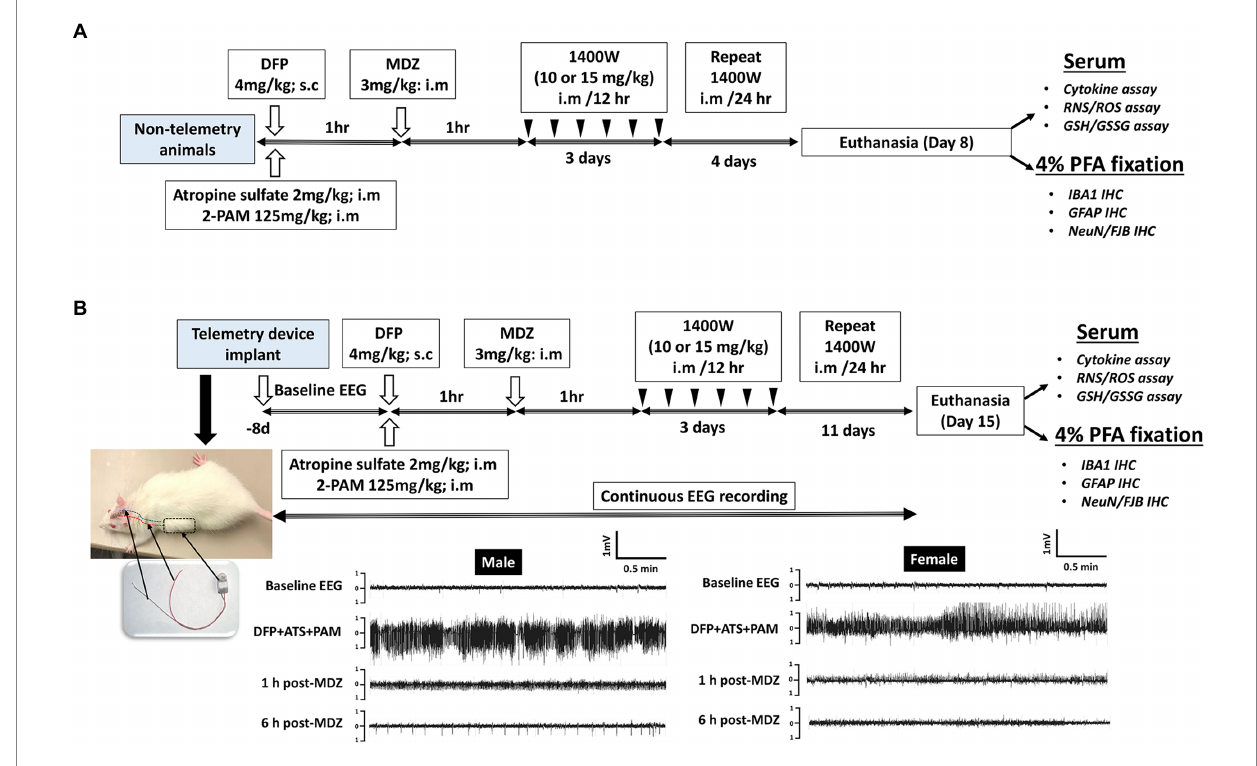
FIGURE 1 Experimental design for non-telemetry (A) and telemetry groups (B) illustrating the DFP exposure, intervention, and the endpoints.